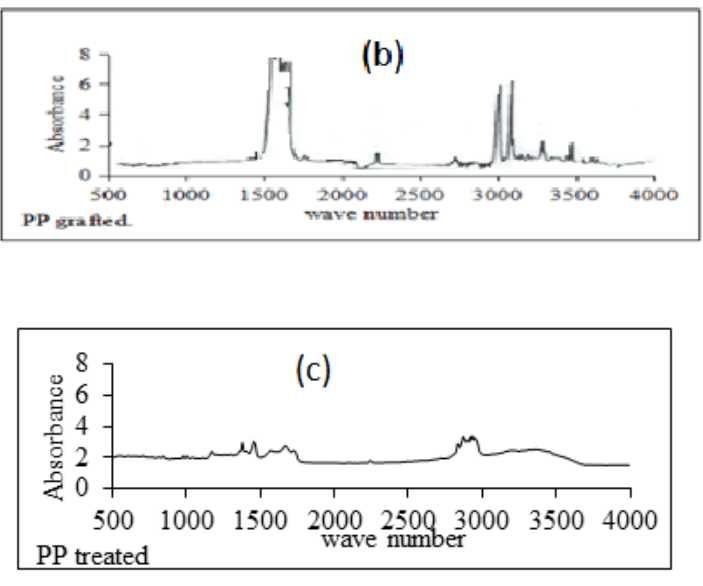
Figure 6. FTIR spectra for polypropylene. ( a ) pure, ( b ) grafted, ( c ) treated.